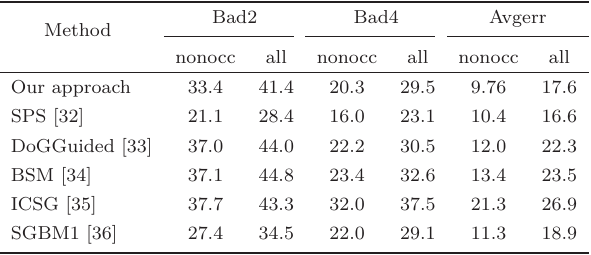
Table 3 Comparison of methods on MV3 Method